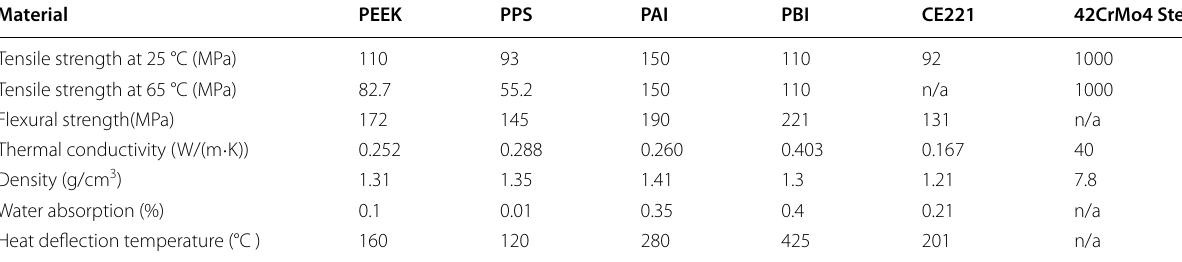
Table 3 Properties of high-performance